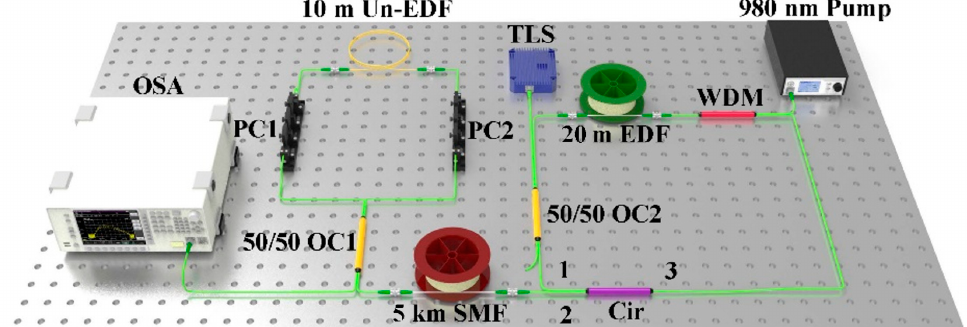
Figure 1. Schematic diagram of the flat MWBEFL based on the use of a Sagnac loop with a Un-EDF. WDM: wavelength-division multiplexer. TLS: tunable laser source. PC: polarization controller. OC: optical coupler. Cir: three-port circulator. OSA: optical spectrum analyzer.